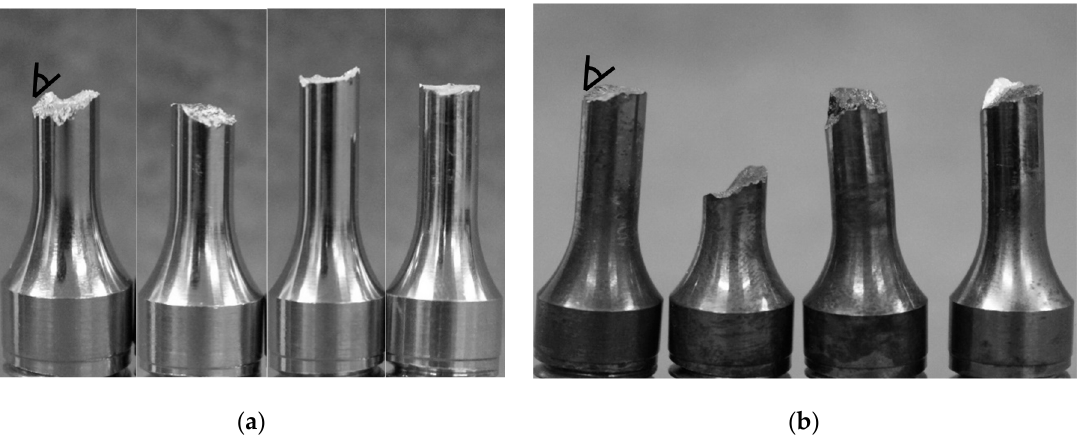
Figure 10. Comparison of the fracture surface morphologies of Alloy 617 weldments at: ( a ) Room temperature; ( b ) 800 °C condition. From left to right i.e. , total strain range of 0.6%, 0.9%, 1.2%, 1.5%.